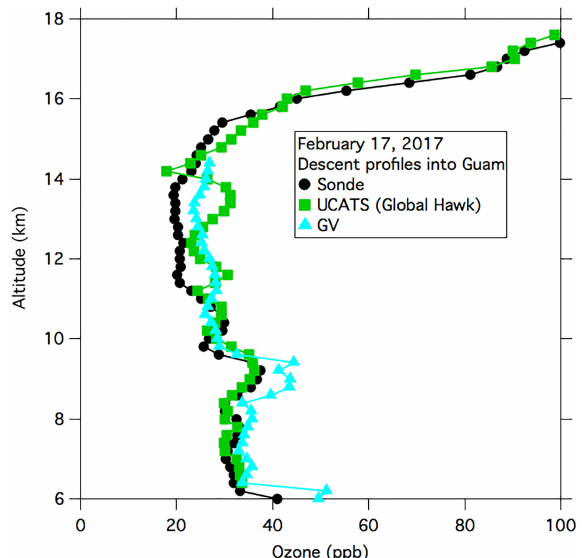
Figure 7. Intercomparison of UCATS descent ozone profile on RF02 with nearby profiles from the Gulfstream V and an ozonesonde. The Global Hawk profile was measured between 09:20 and 10:45UTC, the sonde between 08:46 and 10:44UTC and the Gulfstream V between 05:02 and 05:23UTC.